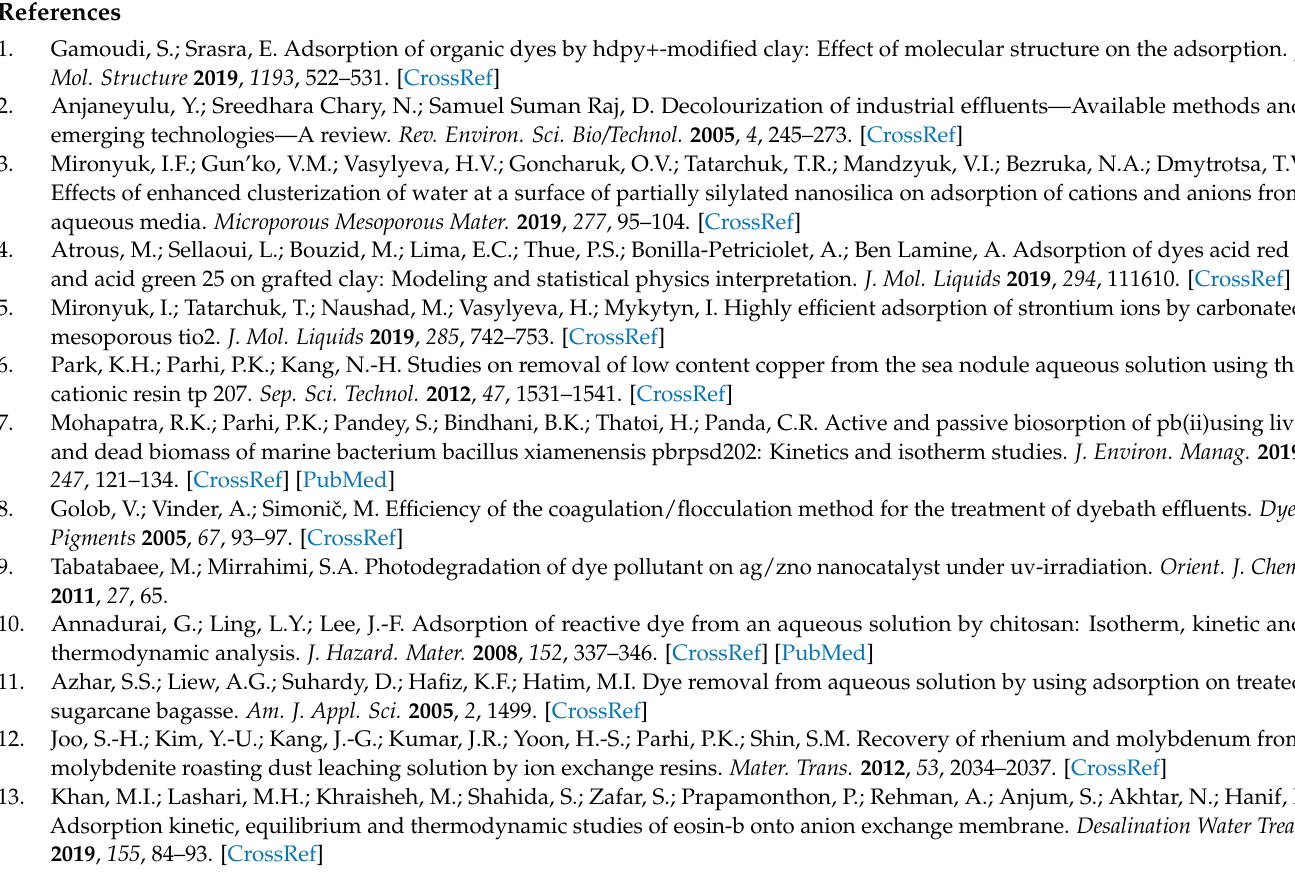
membrane., Figure S2: 1 H NMR spectra of BPPO indicating successful bromination of PPO, Figure S3: SEM image of surface and cross-section of the grafted-anion exchange membrane representing homogeneous morphology. Figure S4: (a) MO aqueous solution before adsorption of methyl orange onto the DMEA-grafted AEM, (b) MO aqueous solution after adsorption methyl orange onto the DMEA-grafted AEM representing effect of membrane dosage on adsorption of MO dye from aqueous